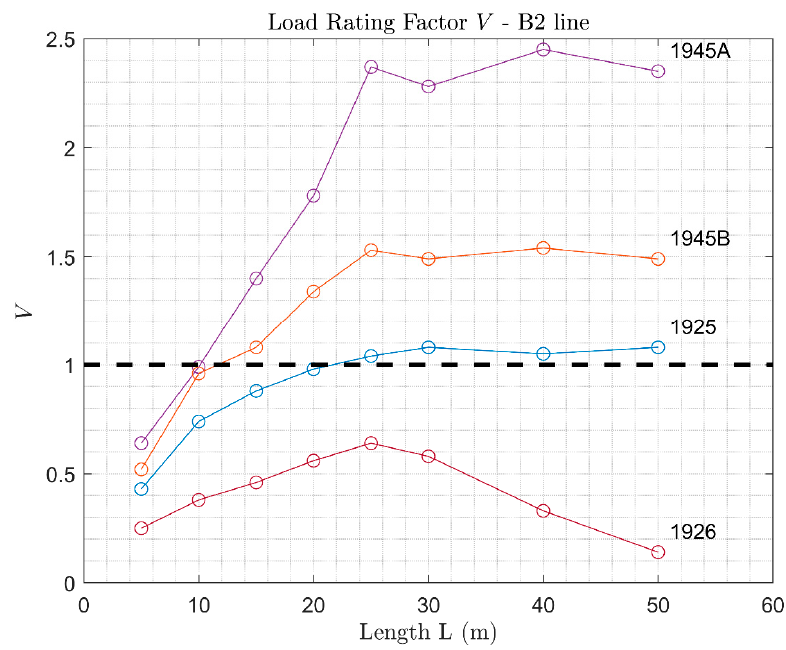
Figure 14. Load Rating Factor of arches verified with B2 loads, with dynamic amplification.